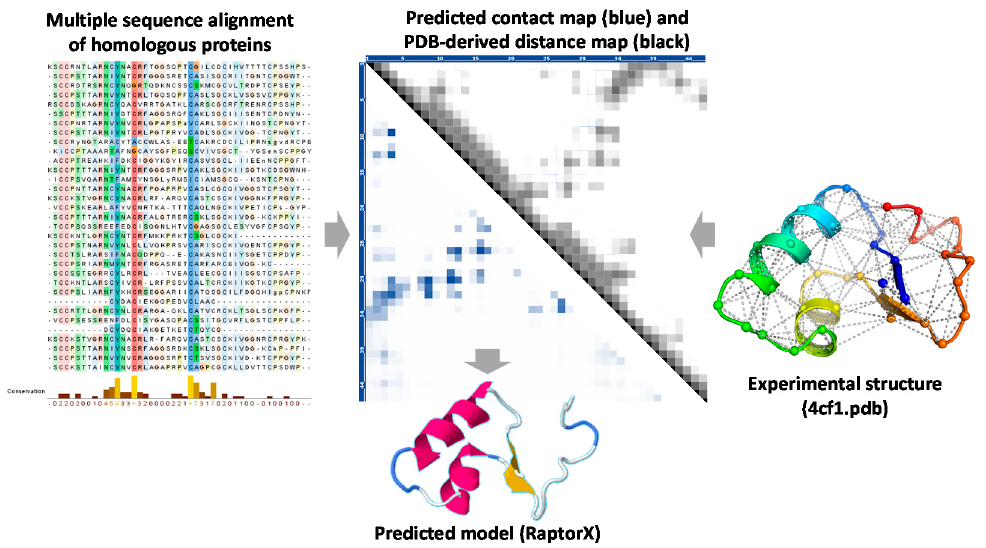
Figure 2. Contact map of the exemplary small protein Crambin (UniProt id: P01542). ( left ) Part of the multiple sequence alignment of the homologous proteins of Crambin. ( middle, lower half ) Contact map and the corresponding 3D model predicted by RaptorX. A contact is defined by C β -C β distance ≤ 8 Å. Darker color indicates a higher probability. ( middle, upper half ) Distance map based on the 3D experimental structure of the protein. The map was visualized using the VMD plugin. The C α –C α distance for each pair is plotted and colored black at 0.0 Å distance, to a linear grayscale between 0.0 and 10.0 Å, and white when equal to or greater than 10.0 Å. ( right ) X-ray crystal structure of Crambin (PDB id: 4fc1) overlaid with the contact (C α -C α , cutoff distance 8 Å) marked in gray dashed lines.